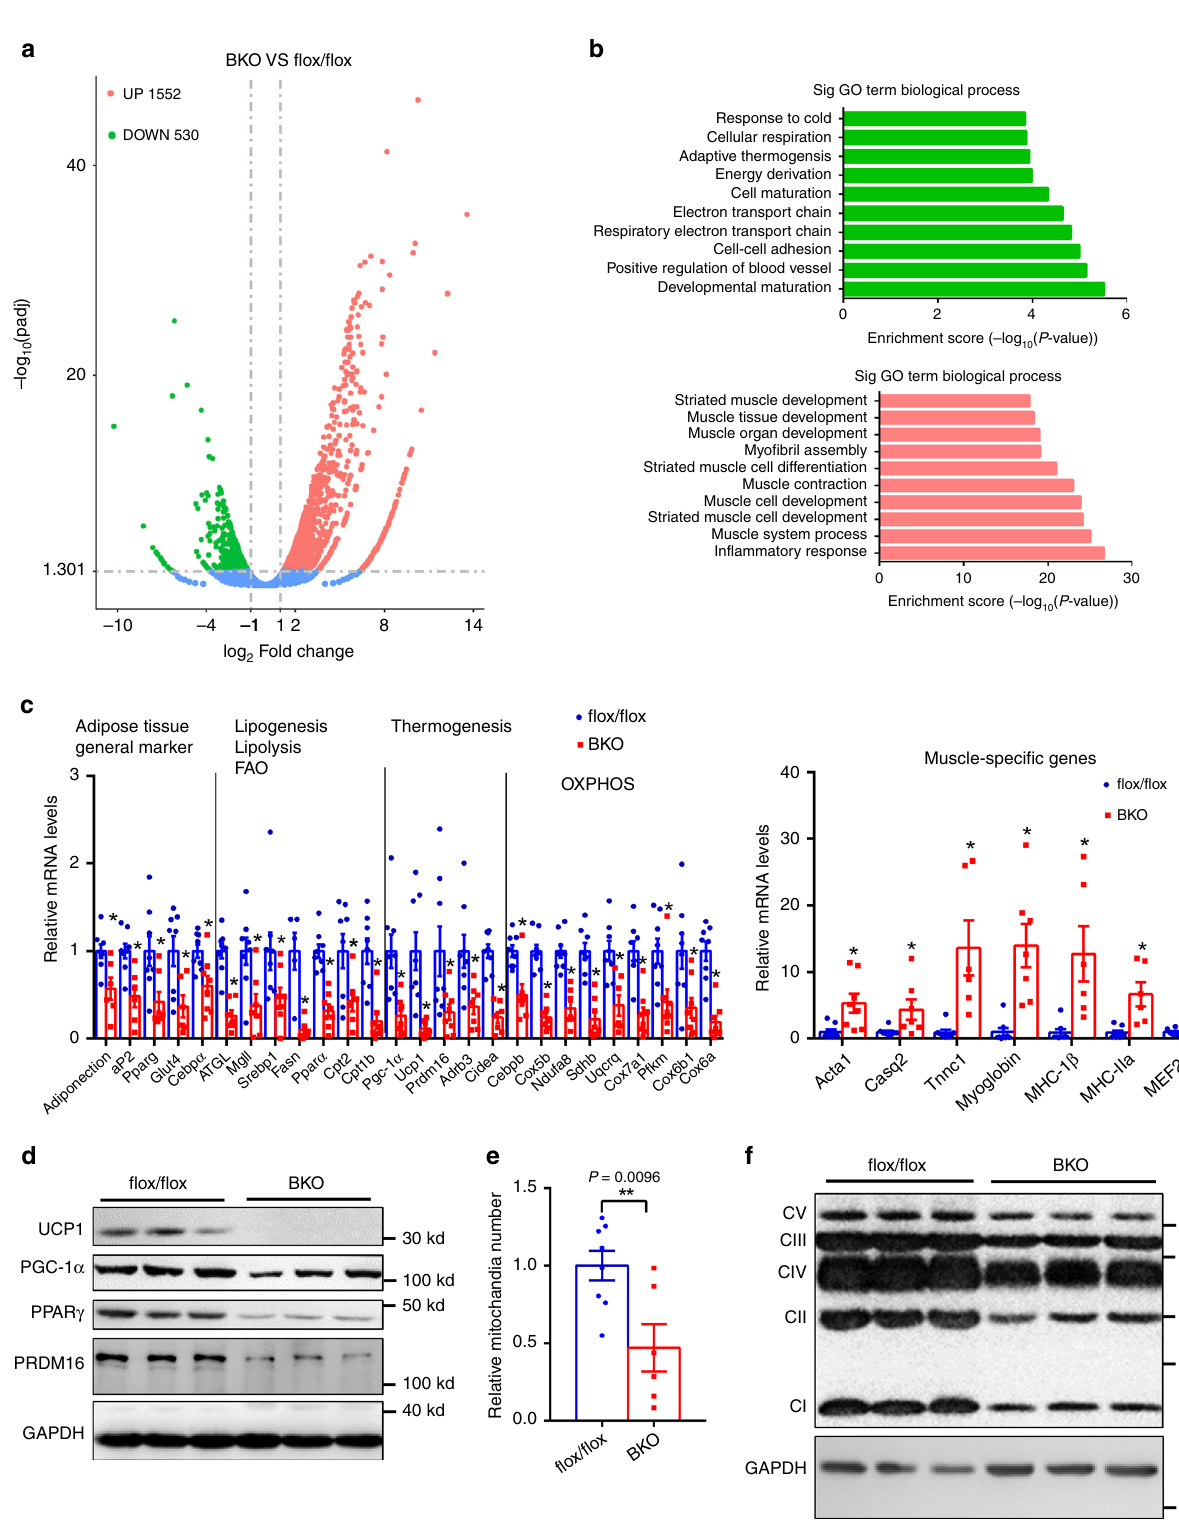
Fig. 3 BAT-speci fi c deletion of Mettl3 dramatically decreases expression of BAT-selective genes RNA-seq analysis was performed in the iBATs of Mettl3 fl ox/ fl ox and BKO mice at 8 weeks old. a The differentially expressed genes (DEGs) (BKO VS fl ox/ fl ox) including 530 downregulated genes and 1552 upregulated genes were illustrated in a volcanoplot (fold change > 2 and q value < 0.005). b Top GO biological process terms enriched in downregulated and upregulated genes. c Relative mRNA levels ( n = 5 – 8 for each group). d UCP1, PGC-1 α , PPAR γ , PRDM16, and GAPDH protein levels in iBATs of 8-week-old Mettl3 fl ox/ fl ox and BKO mice were determined by Western blot ( n = 3 for each group). e Relative mitochondria number in iBATs of 8- week-old Mettl3 fl ox/ fl ox and BKO mice ( Mettl3 fl ox/ fl ox , n = 8; BKO, n = 6). f Mitochondrial complex protein levels in iBATs of 8-week-old Mettl3 fl ox/ fl ox and BKO mice were determined by western blot ( n = 3 for each group). Data represent the mean ± SEM. Signi fi cance was determined by unpaired two-tailed Student ’ s t test analysis. * p < 0.05. ** p < 0.01. Source data are provided as a Source Data fi